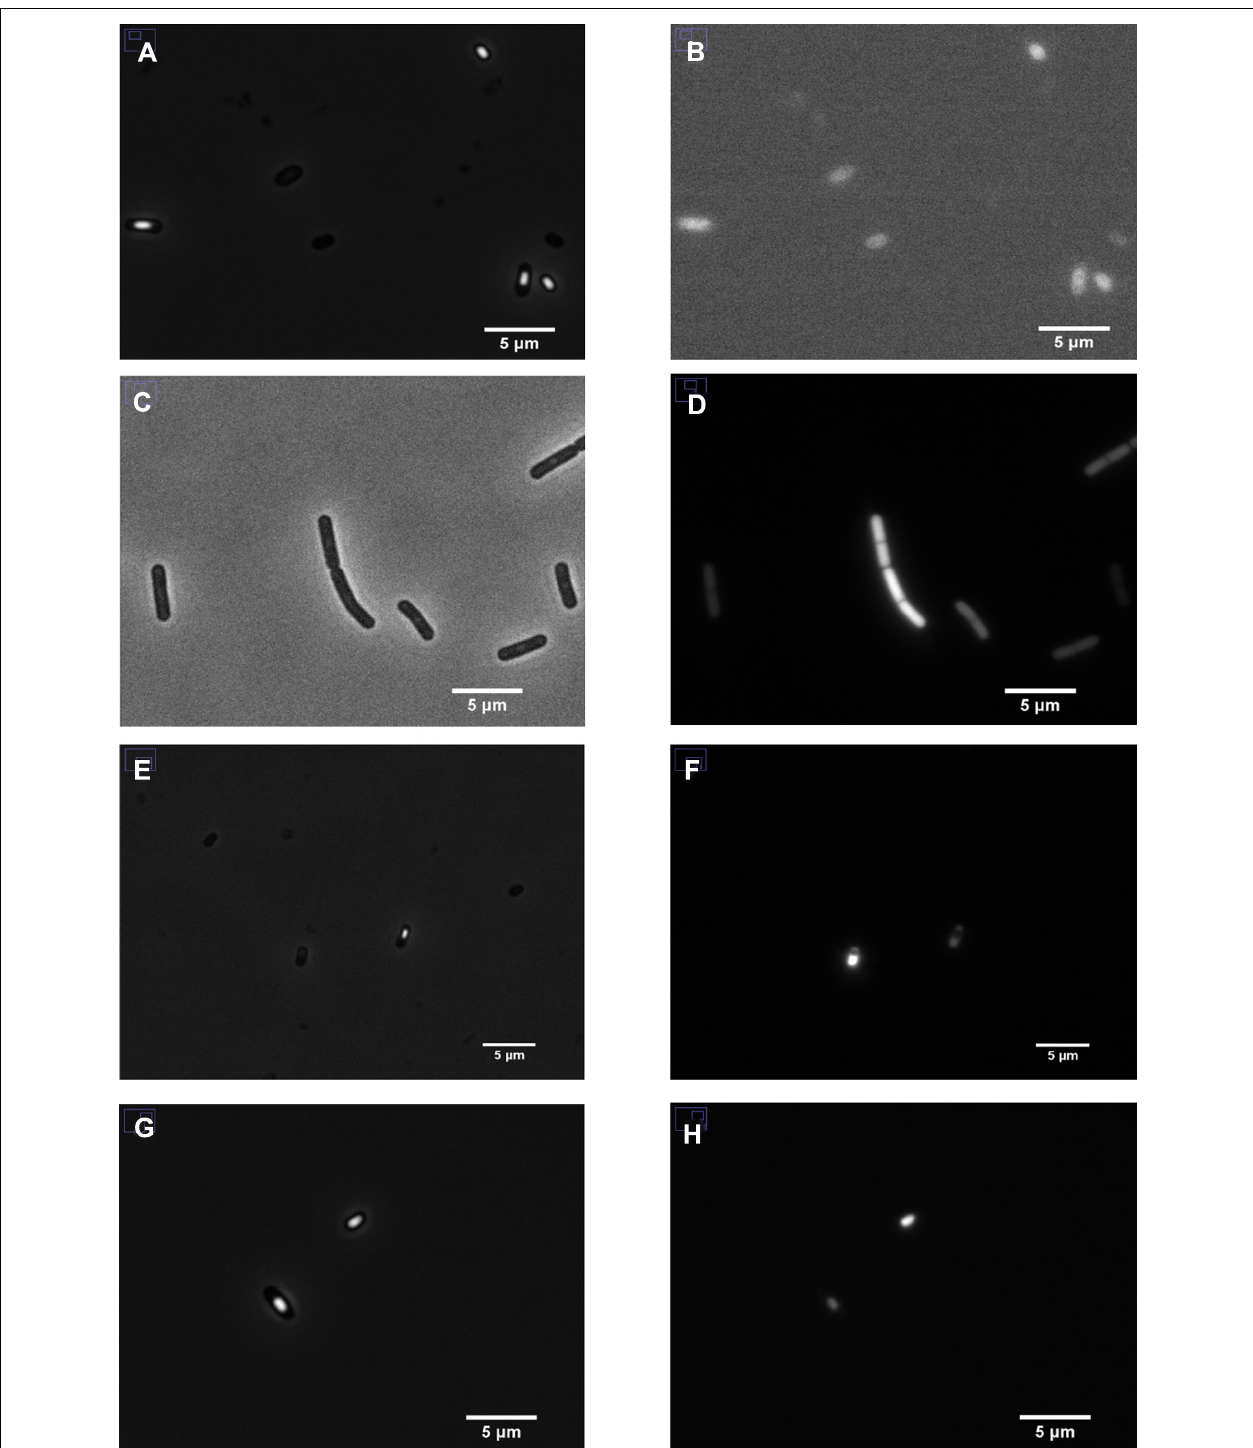
FIGURE 2 | Expression of IpHluorin in B. subtilis PB2. Left panels : phase-contrast images; right panels : corresponding fluorescent signals. (A,B) Non-transformed cells; (C,D) PptsG-IpHluorin-expressing cells; (E,F) sporulating cells expressing PspoIIID-IpHluorin; (G,H) sporulating cells expressing PB2